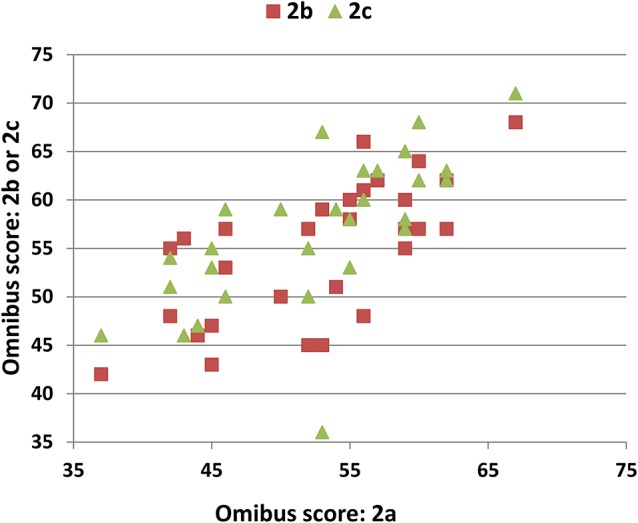
Test-retest reliability. Omnibus scores of the participants in Experiment 2a (abscissa) vs. Experiment 2b or 2c (ordinate).